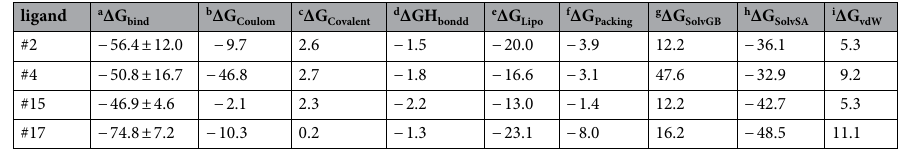
Table 3. Prime MM-GBSA energies (kcal/mol) for ligands binding at the Delta Spike RBD. a Total free energy of binding, in kcal/mol as calculated by the MMGBSA method, averaged over the time of simulation. b Electrostatic Coulomb term of the binding energy. c Covalent term of the binding energy. d Hydrogen bond contribution to the binding energy. e Lipophilic contribution to the binding energy. f π–π packing correction. g Generalized Born term of the solvation energy. H non-polar contribution (SA, Surface Area) to the solvation energy. i van der Waals term of the binding energy.